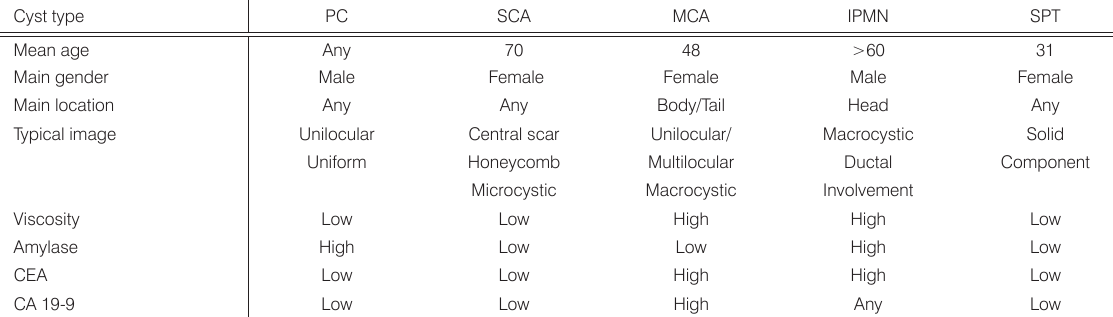
Table 4. Differential diagnosis of pancreatic